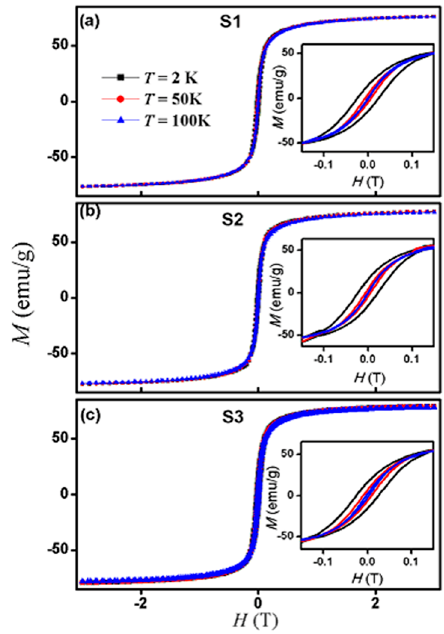
Figure 4. Magnetic field ( H ) dependence magnetization ( M ) for samples ( a ) S1; ( b ) S2; ( c ) S3. The insets show the low filed region around the center of the loops.